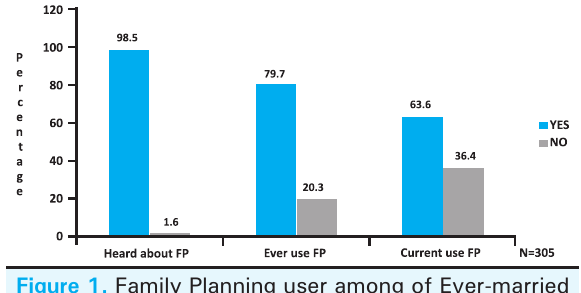
Figure 1. Family Planning user among of Ever-married women under reproductive age of study population.